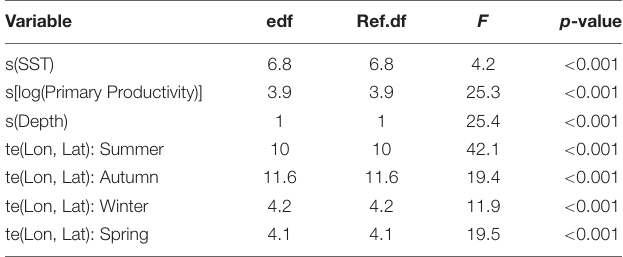
TABLE 2 | GAMM output for juvenile smooth hammerhead resident behavior in relation to environmental variables. Variable